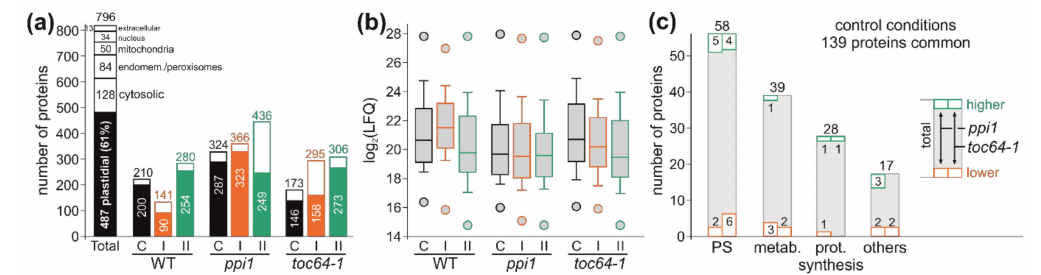
Figure 3. Proteome analysis of chloroplasts. ( a ) The number of identified proteins is shown. “Total” indicates all proteins identified in at least one sample; subsequently, the number of proteins discovered in individual samples is shown (black: control, orange: HS-I, green HS-II). The full bar indicates the fraction of plastid localized proteins based on SUBA, and the open segment indicates the fraction of proteins with localization to other cellular sub-compartments. The total number of discovered proteins is indicated on top. ( b ) The box plot of the log 2 (LFQ) value distribution with indicated maximal and minimal values is shown for each fraction. ( c ) The proteins detected in all three genotypes under control conditions are compared. The total number of proteins involved in photosynthesis (PS), metabolism, protein synthesis, and other process is shown, and proteins with lower (red) or higher (green) abundance in the mutants relative to wild-type plants are shown as indicated on the